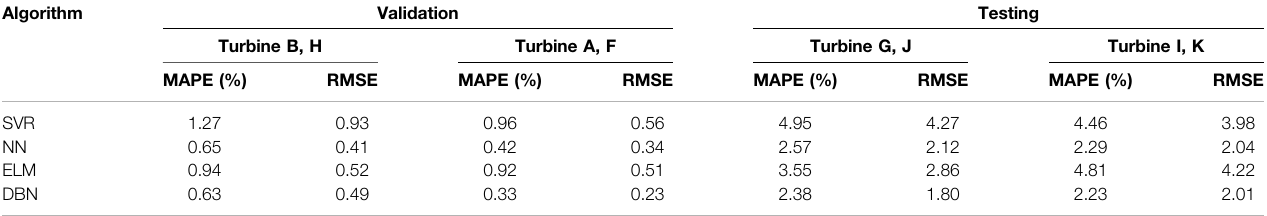
TABLE 3 | Performance evaluation of four algorithms. Algorithm